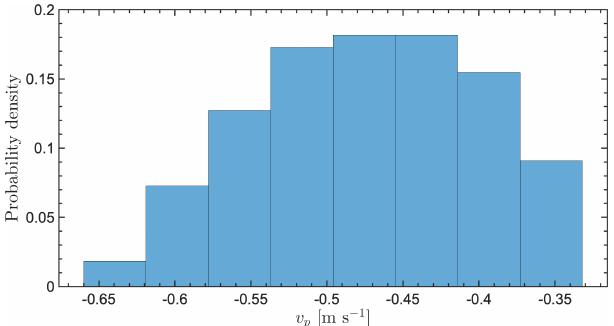
Figure A3. Simulated particle fall speed distributions for a horizon- tal wind speed of 5ms − 1 .